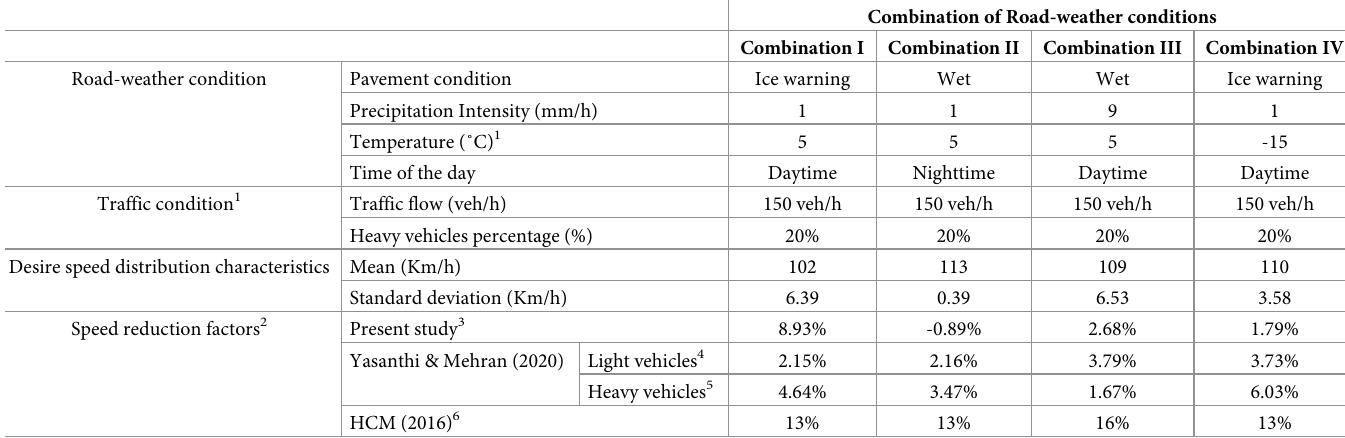
Table 4. Comparison of results with past